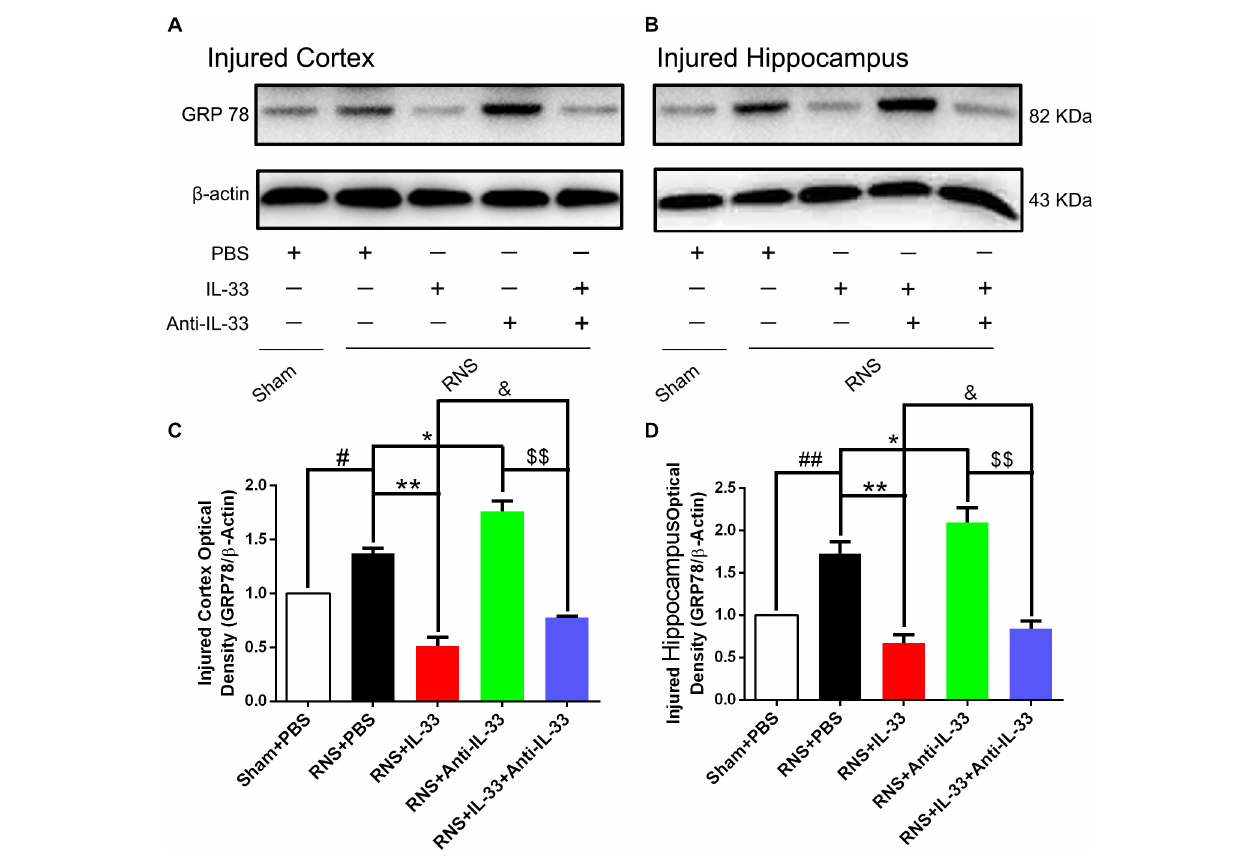
FIGURE 7 | IL-33 negatively regulated RNS-induced ERS responses. (A,B) Administration of IL-33 alone reversed RNS-induced up-regulation of the expression level of ERS related-protein GRP-78, while Anti-IL-33 alone treatment further up-regulated the expression level of GRP-78. However, the combined treatment of IL-33 and Anti-IL-33 reversed the effect of IL-33 alone or Anti-IL-33 on the expression level of GRP-78 in both cortex and hippocampus at 72 h post-RNS. (C,D) Optical densities of the protein bands were quantitatively analyzed, and normalized with loading control β -actin. The data were expressed as means ± SEM ( n = 4–6). ## P < 0.01 vs. Sham + PBS group, # P < 0.05 vs. Sham + PBS group. ** P < 0.01 vs. PBS group, * P < 0.05 vs. PBS group. & P < 0.05 vs. RNS + IL-33 group. $$ P < 0.01 vs. RNS + Anti-IL-33 group. Experiments are representative of three independent